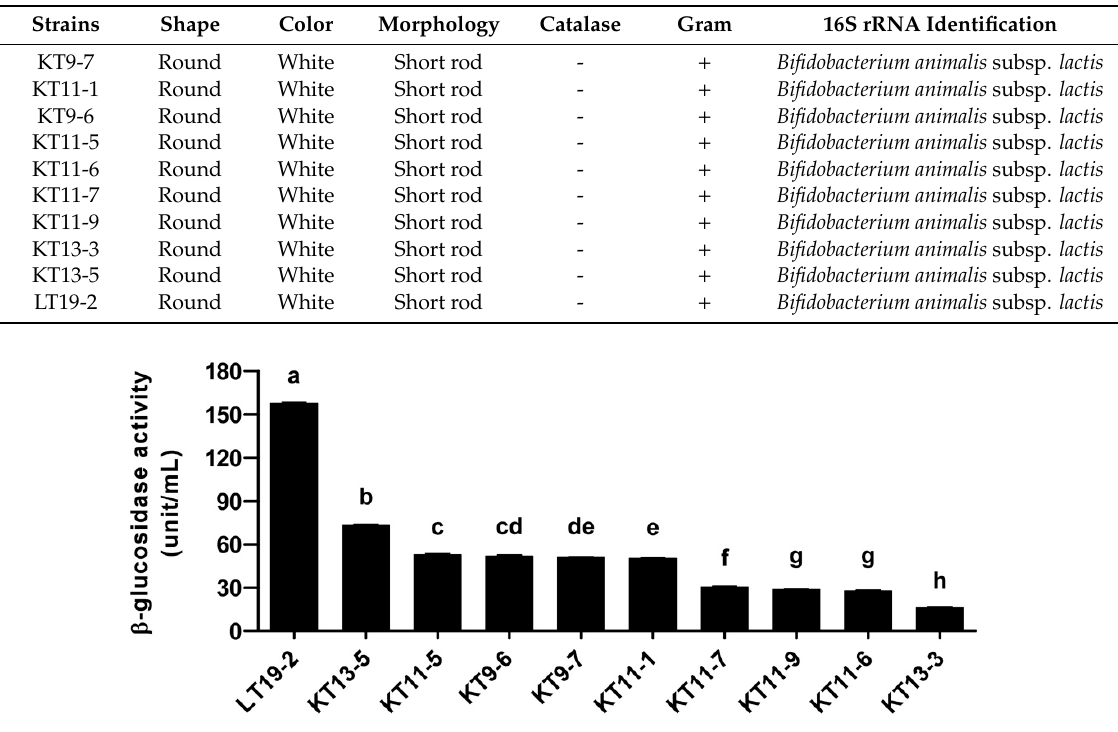
Figure 3. LT 19-2 showed the highest β -glucosidase activity in selected 10 strains. Data are represented as mean ± SEM values of three independent experiments. Mean values with di ff erent letters over the bars indicate significant di ff erence ( p <